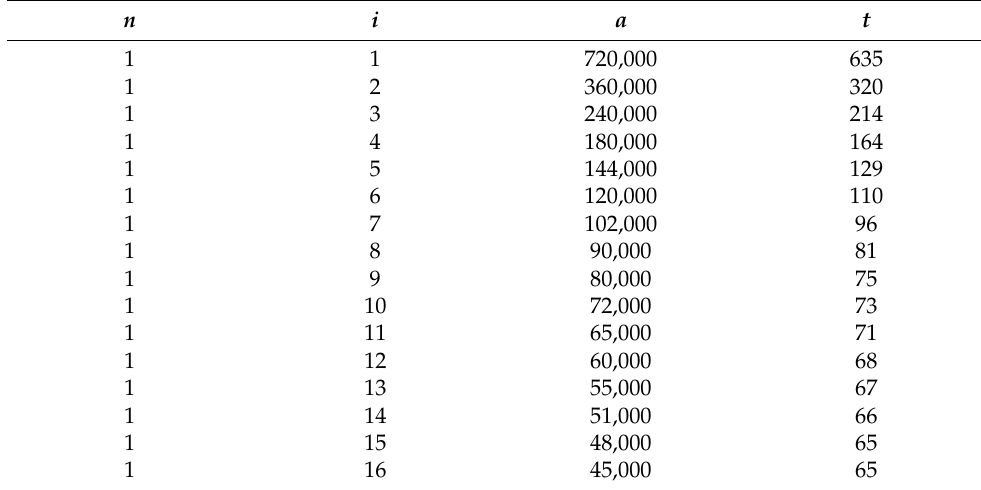
Table 4. Scalability, initial run on a single server with n GMAF instances.